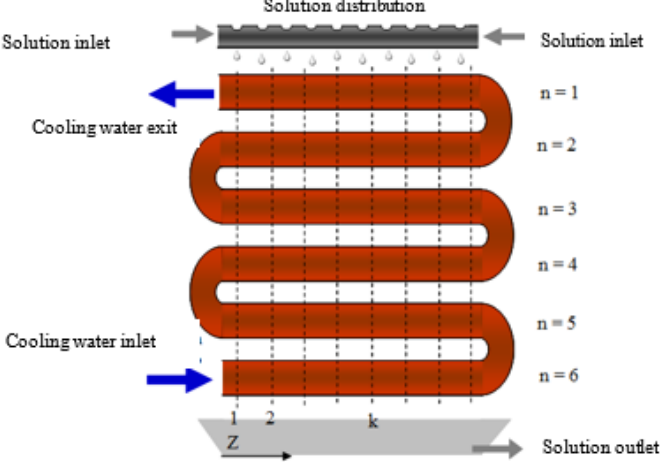
Figure 2. Schematic diagram of the horizontal tube falling ‐ film absorber.